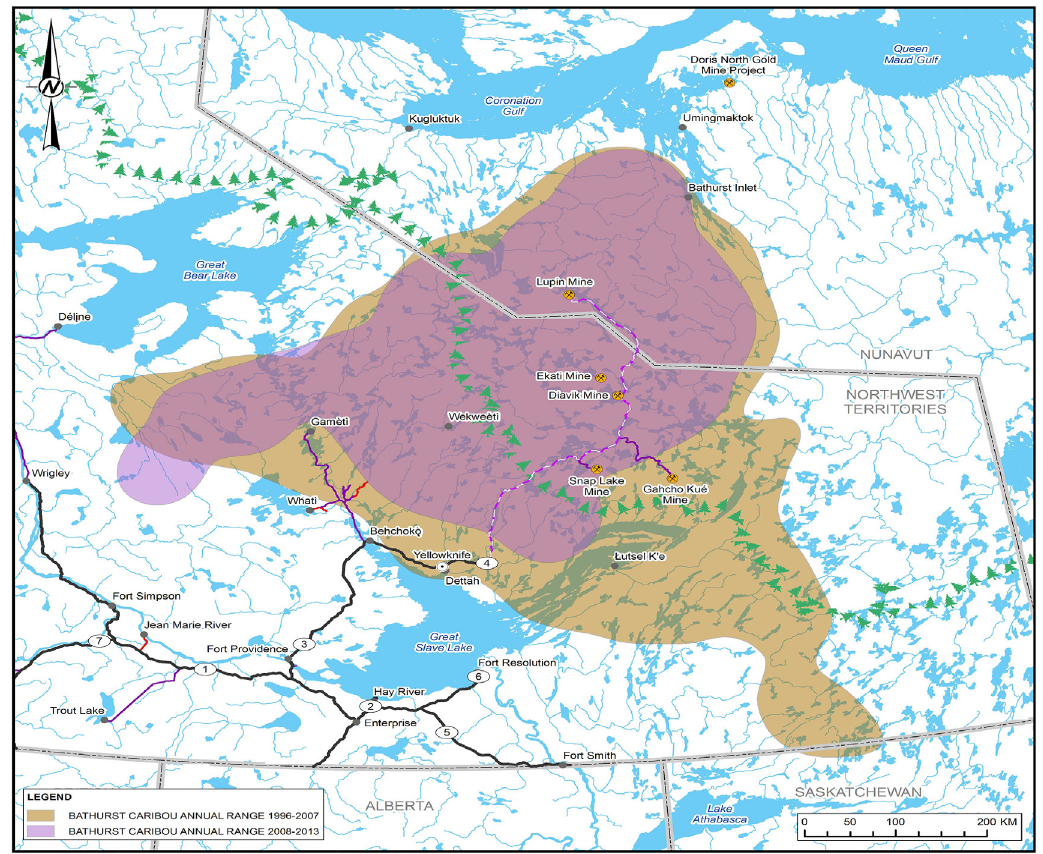
Figure 2. Annual range of Bathurst radio-collared females, 1996 to 2007 and 2008 to 2013, in northcentral